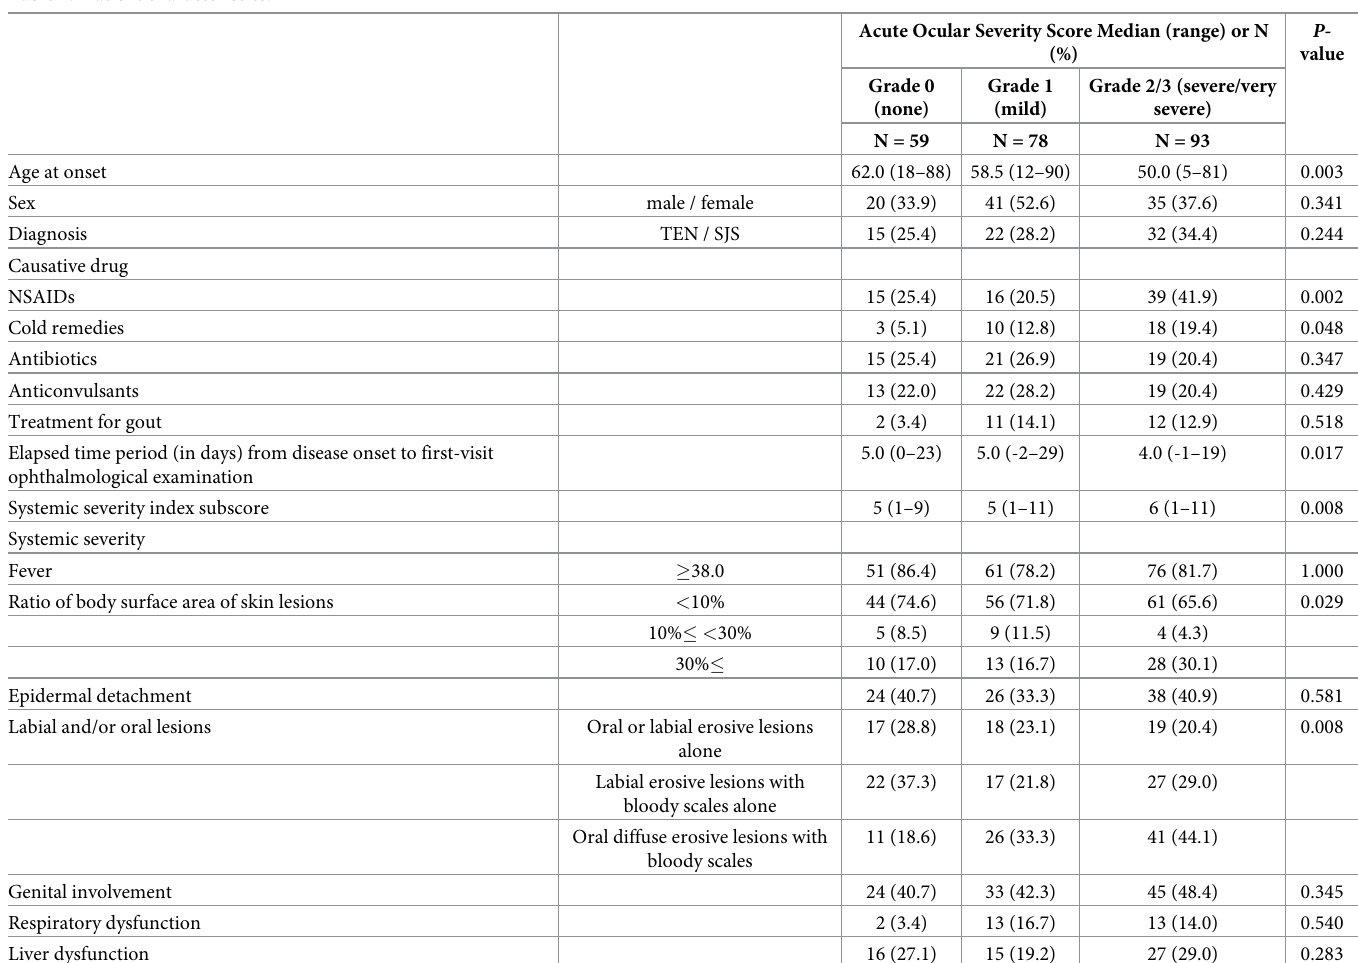
Table 2. Patient